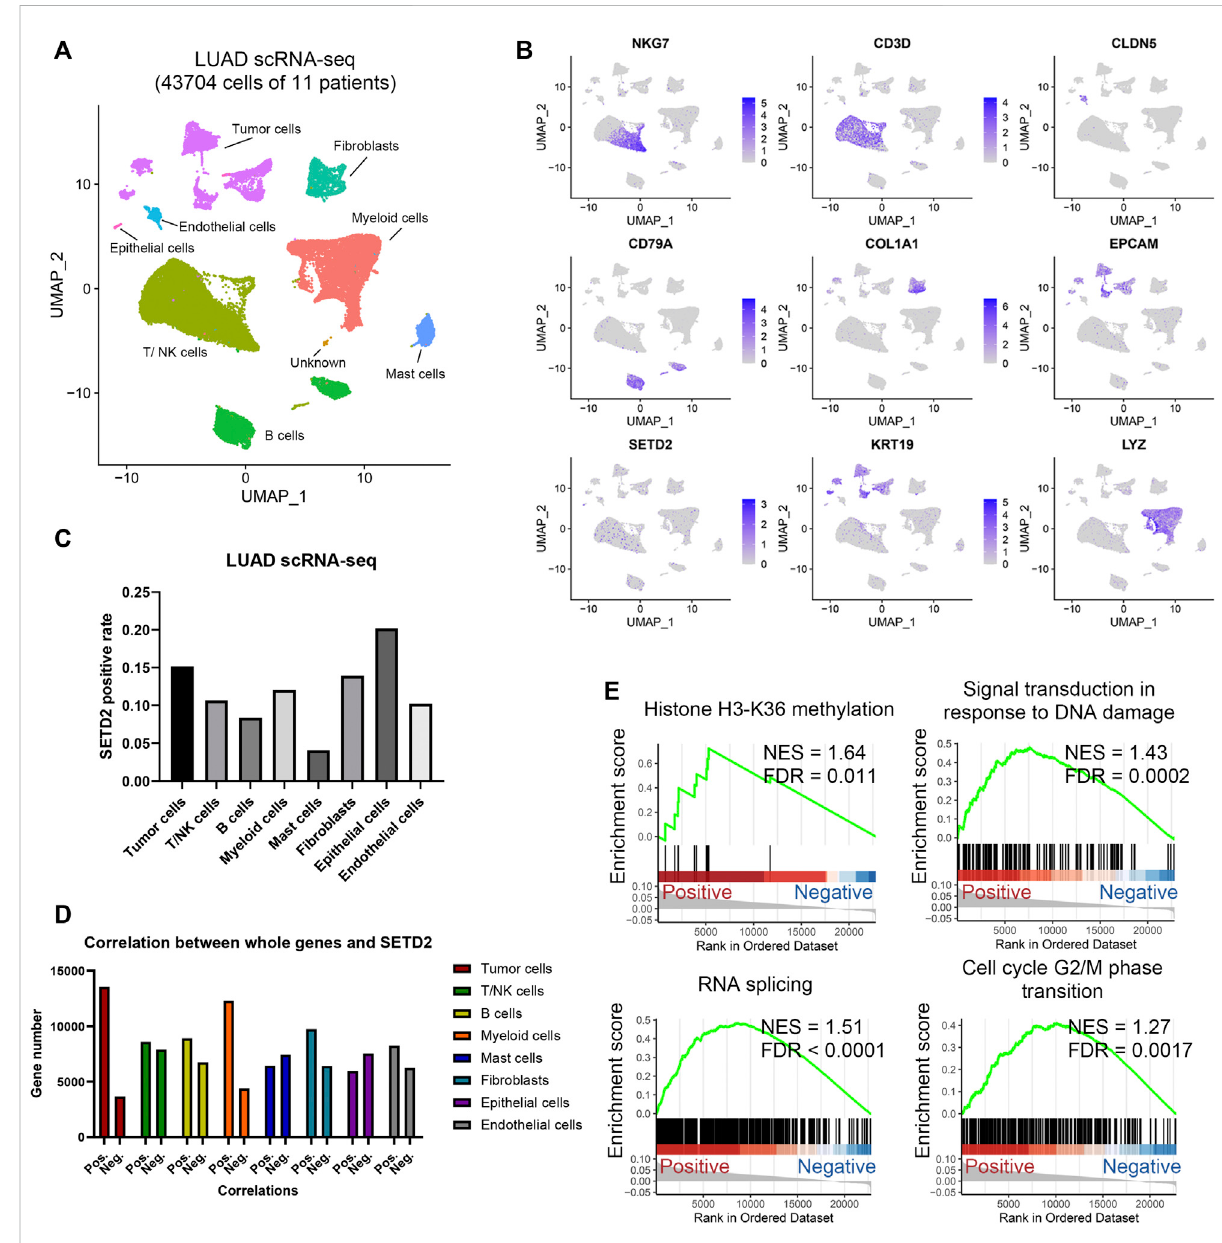
FIGURE 5 AnalysisofSETD2inLUADscRNA-seq. (A) UMAPofthe43,704cellsinLUADscRNA-seq. (B) MarkergeneexpressionsinscRNA-seq. (C) Positive rate of SETD2 for each cell type. (D) The number of genes positively or negatively correlated with SETD2 expression. (E) GSEA of positive SETD2 vs. negative cells in